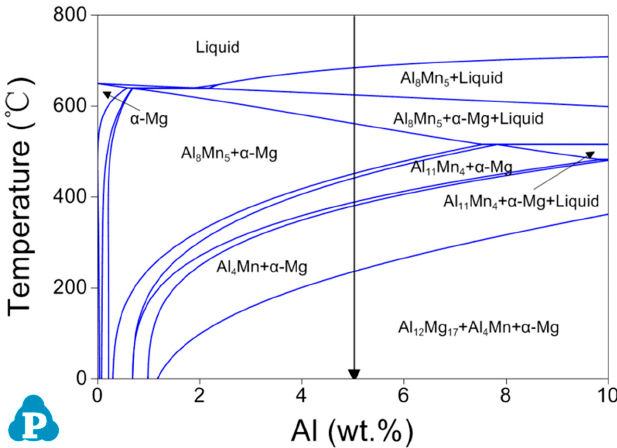
Figure 5. Section of Mg-0.5Mn-Al system calculated using the Pandat software. Materials 2017 , 10 , x FOR PEER REVIEW